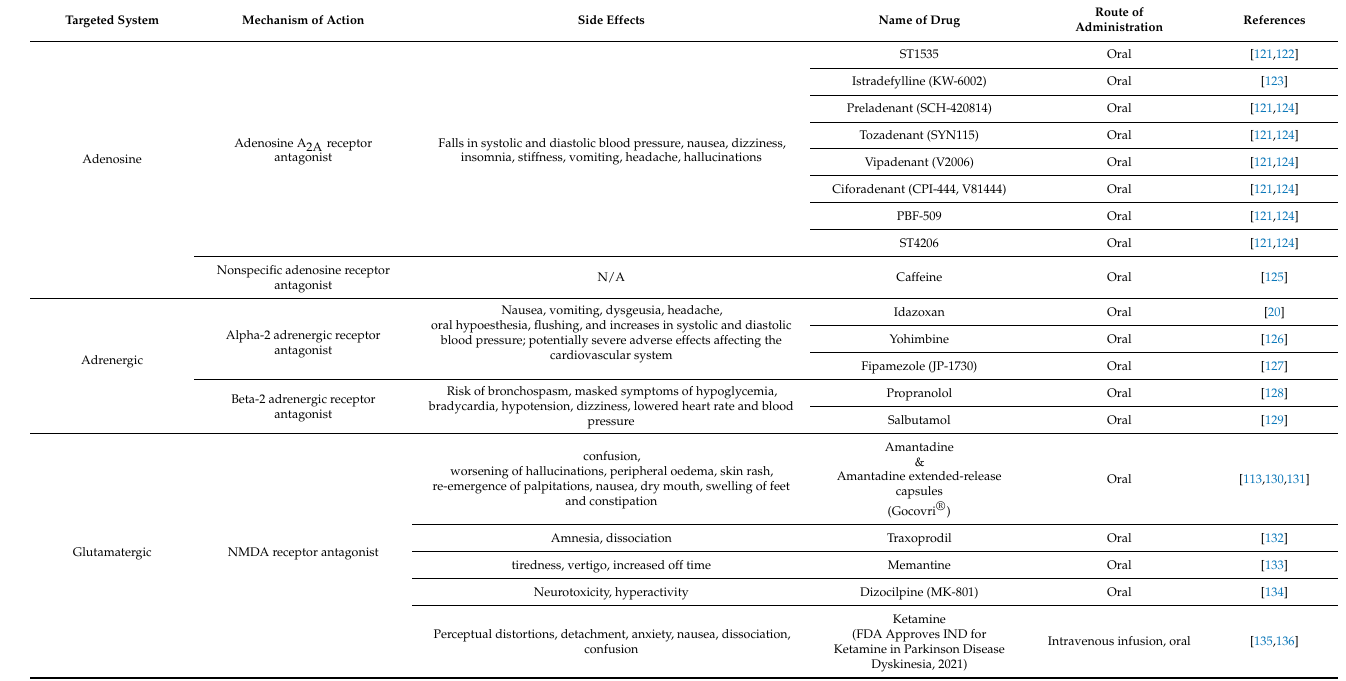
Table 4. Non-Dopaminergic